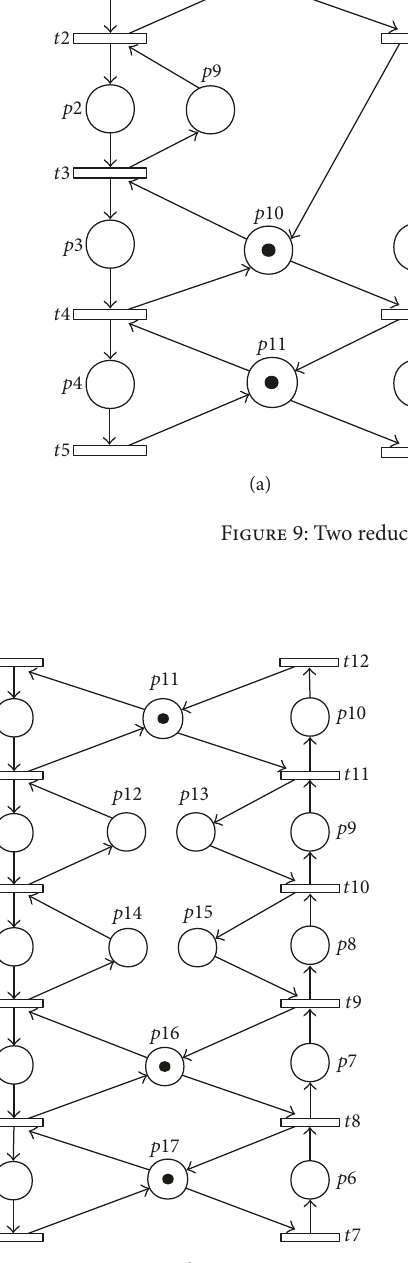
Figure 10: An S 3 PR